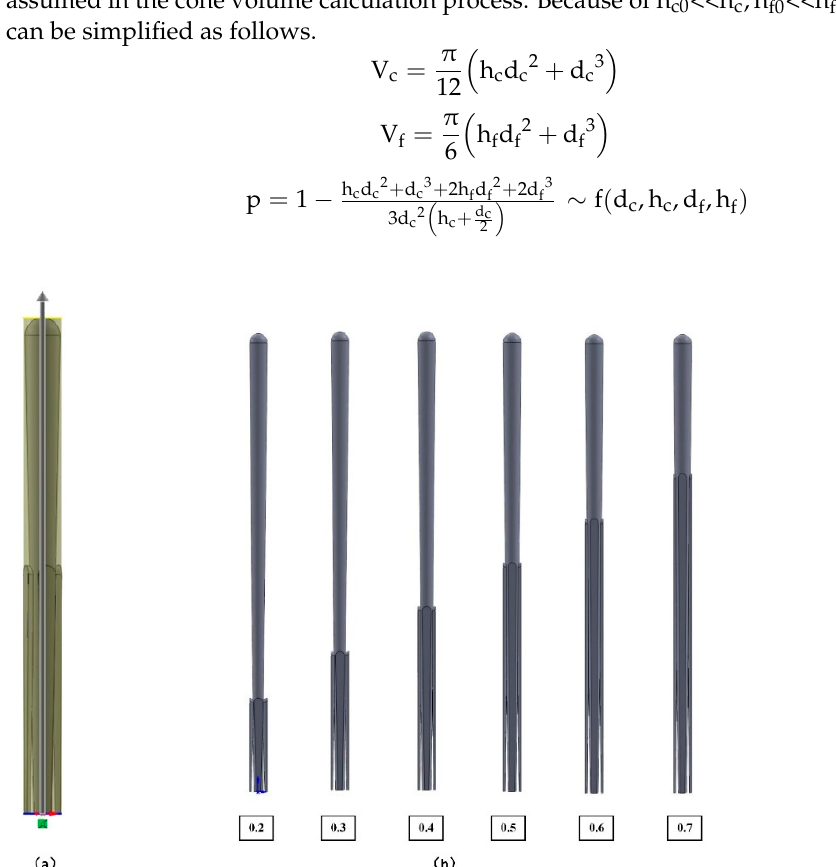
Figure 10. ( a ) Calculation diagram of porosity p and ( b ) coating models with different ratio γ . Then, the dependence of the effective thermal conductivity on the ratio γ of the height of fine column to coarse column was studied based on the finite element model of coating. Keep the thickness of the coating and the diameter of the coarse column constant, change the ratio γ , and the models with different ratio γ are presented in Figure 10b. The calculated results of the effective thermal conductivity are shown in Figure 11, in which there is an increase of the effective thermal conductivity as the ratio γ of coating increases. According to the analysis of mathematical model Equation (14) of the porosity of the coating, the porosity decreased linearly as the height of the fine column h f increased, which caused the effective thermal conductivity to increase. As the ratio of the height of fine column to coarse column increased, a greater volume of fine columns filled in the gap between the coarse columns and the discontinuity in the horizontal direction of the coating decreased, thereby increasing the effective thermal conductivity